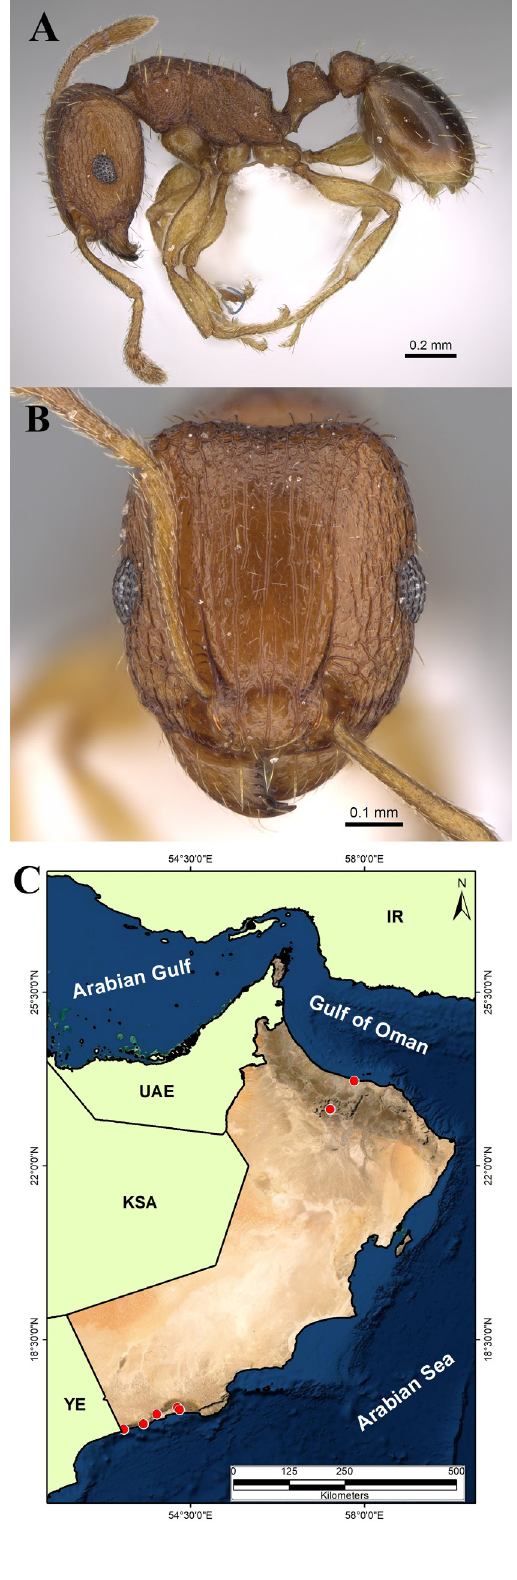
Fig. 48. Tetramorium caldarium (Roger, 1857), worker (CASENT0922858, AntWeb.org (Michele Esposito)). A . Body in profile. B . Head in full-face view. C . Distribution